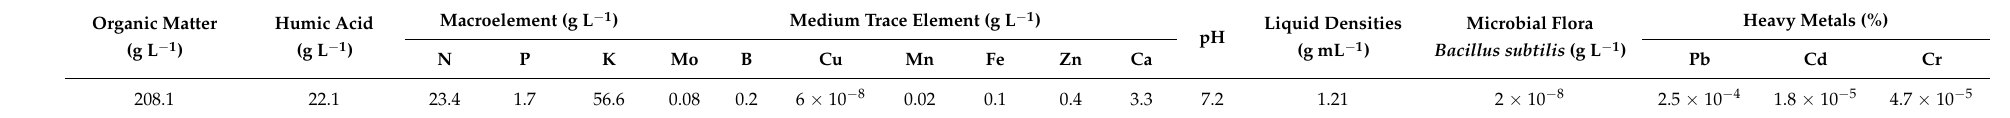
Table 2. Properties of the organic wastewater used in this